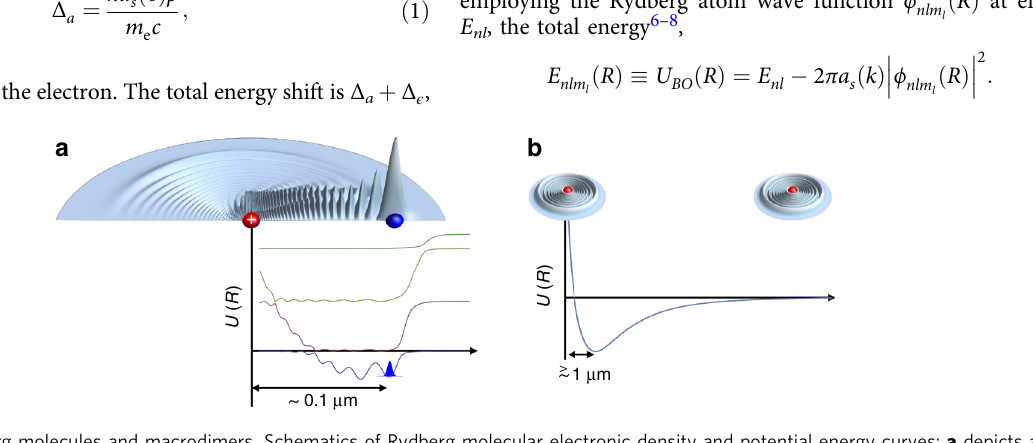
( r ) = ( r − a s (0)) ψ , with a s (0) = − lim electron-scattering length, obtained in the zero-momentum limit